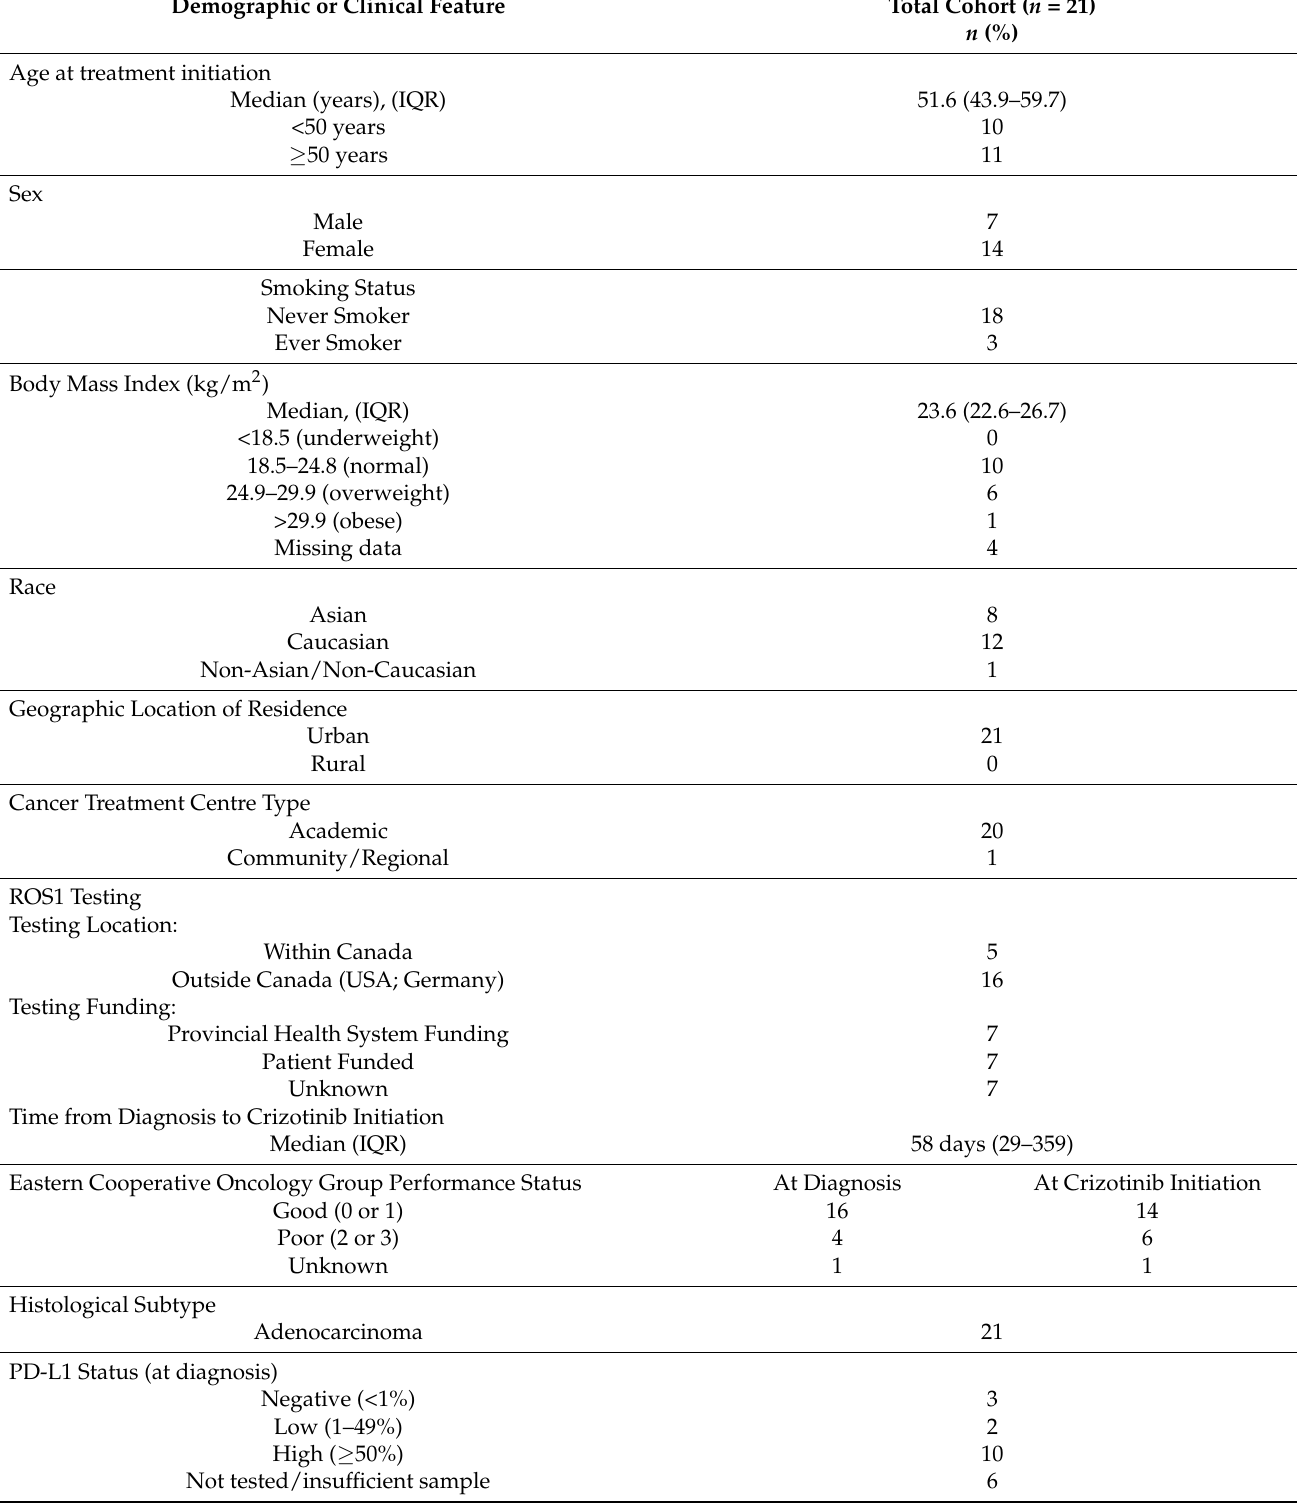
Table 1. Demographic and clinical features for crizotinib-treated ROS1-rearranged cohort. Demographic or Clinical